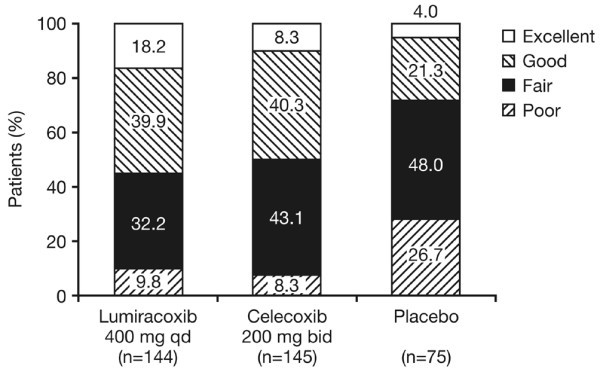
Patient's global evaluation of treatment effect at study end.